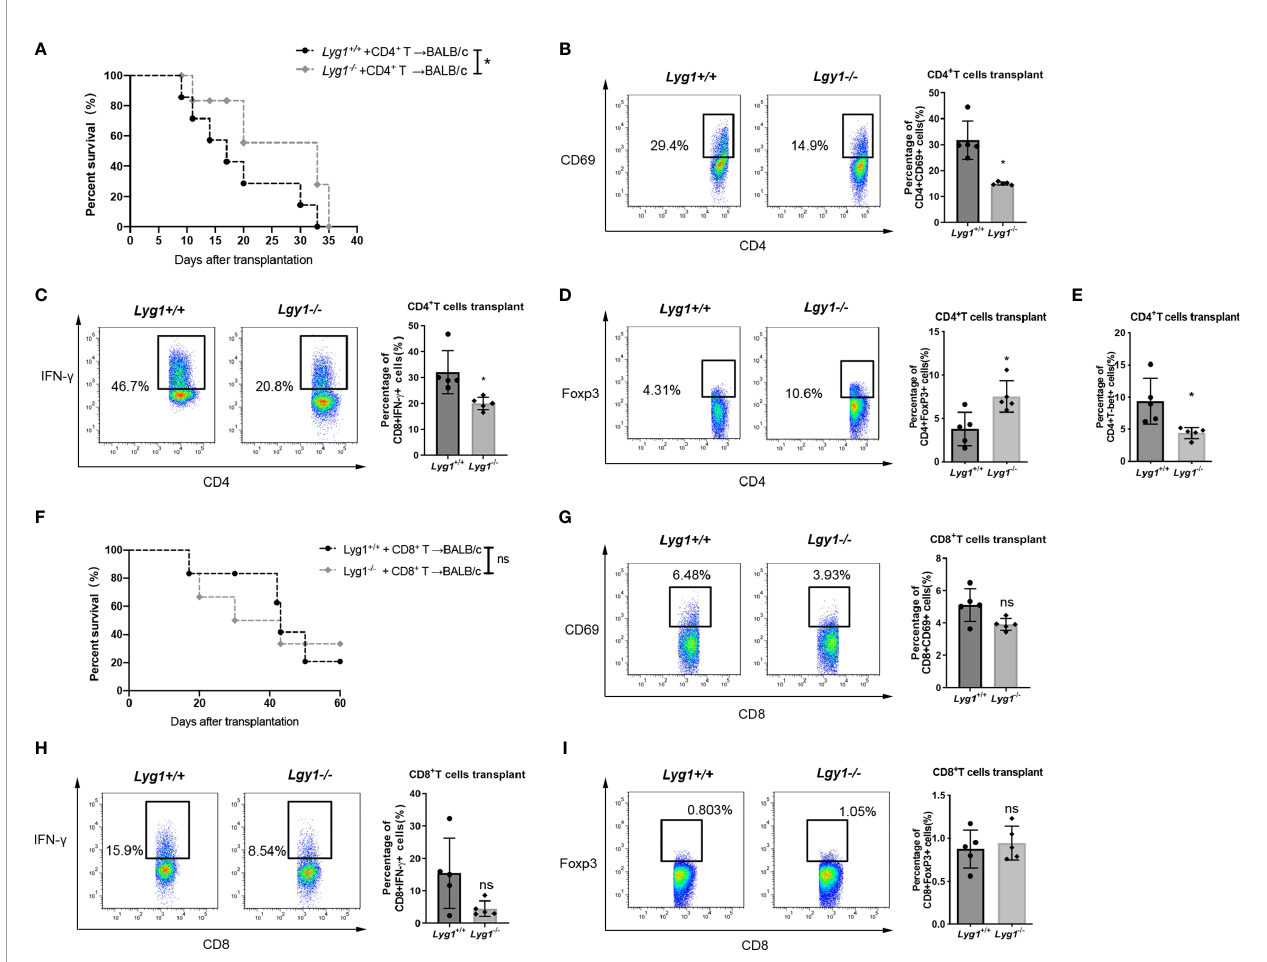
FIGURE 6 | LYG1 mediated aGVHD development mainly through CD4+ T cells. Survival of mice receiving CD4 + (A) and CD8 + (F) donor T cells were monitored. Data pooled: n = 10 for Lyg1 +/+ group and Lyg1 -/- group (A, F) . (B – E) The expression of CD69, IFN- g , Foxp3 and T-bet gated on CD4 + T cells. (G – I) The expression of CD69, IFN- g and Foxp3 gated on CD8 + T cells. n = 5 per group (B – E, G – I) . Representative plots are shown and statistical results are expressed as the mean ± SD, *p < 0.05 compared with Lyg1 +/+ group. ns, no signi fi